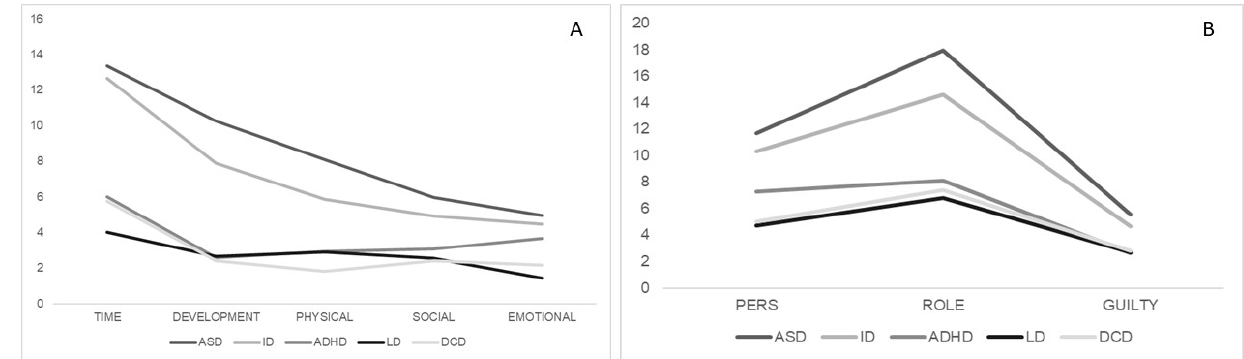
Figure 3. Graphic representations of different profiles of burden levels (( A ) subscales of Caregiver Burden Inventory; ( B ) subscales of Zarit Caregiver Burden Scale) across the 5 subgroups of caregivers.